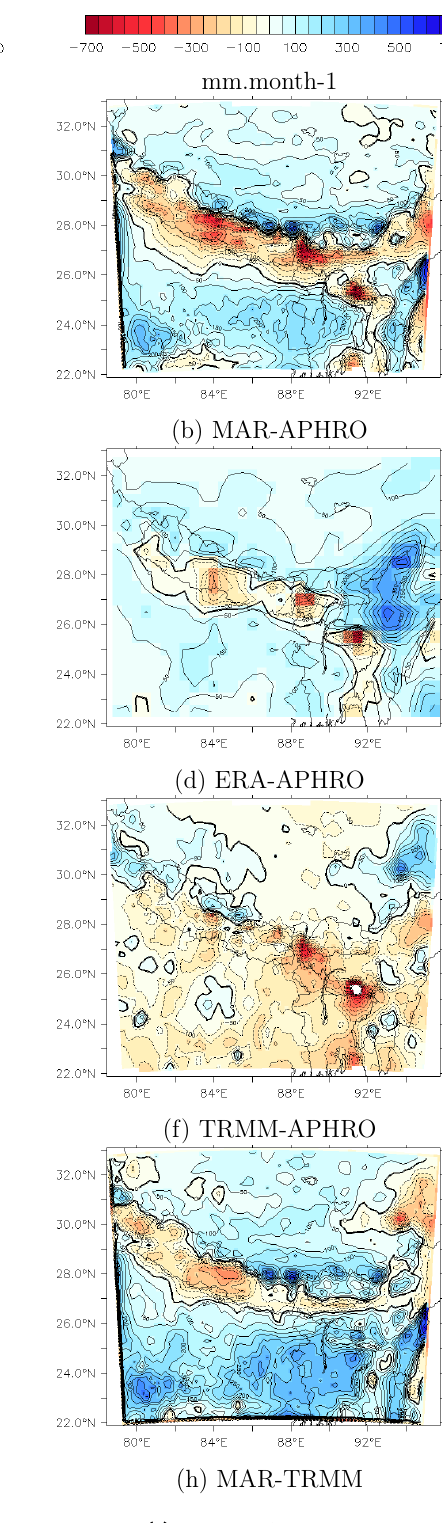
Fig. 3. Monsoon (JJAS) 2001 precipitation (mmmonth − 1 ): (a) simulated with MAR, (c) estimated from ERA-INTERIM, (e) evaluated from TRMM, and (g) observed with APHRODITE network. Figures in the right column correspond to the differences (b) MAR-APHRODITE, (d) ERAINTERIM-APHRODITE, (f) TRMM-APHRODITE, and (h)